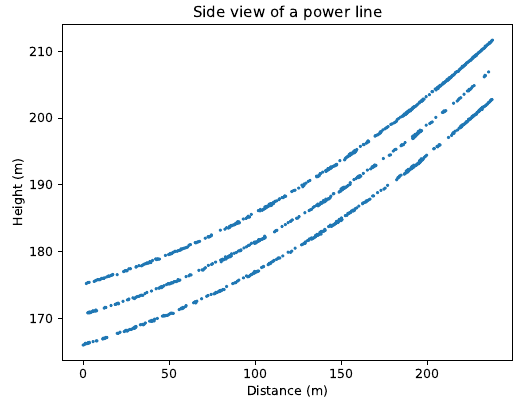
Figure 3. Distribution of points in the vertical plane of a power line with three